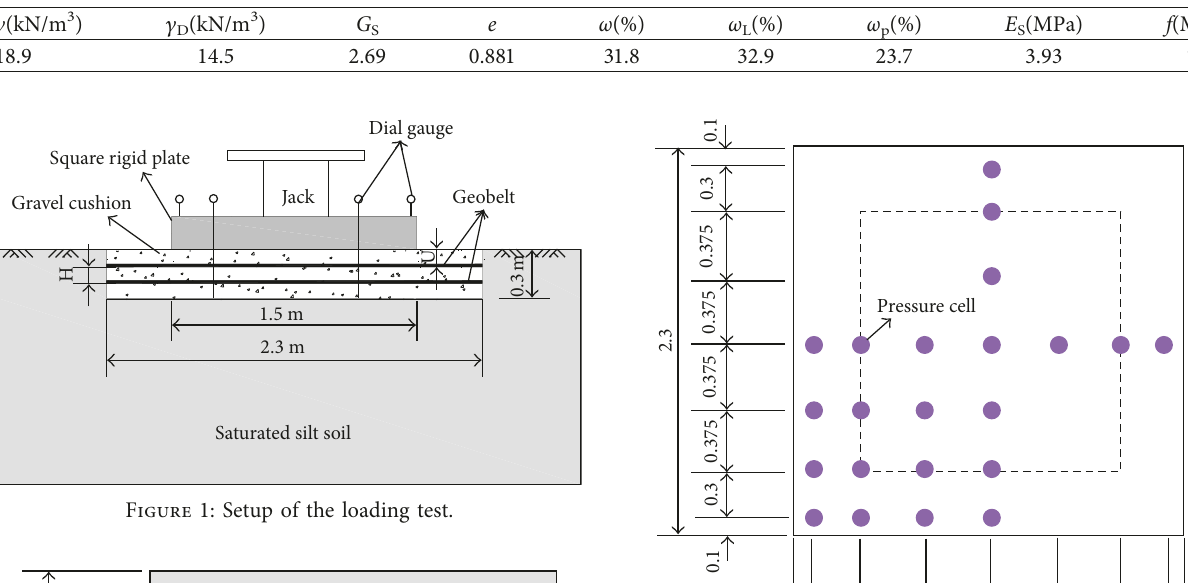
Table 1: Physical and mechanical parameters of silt soil.